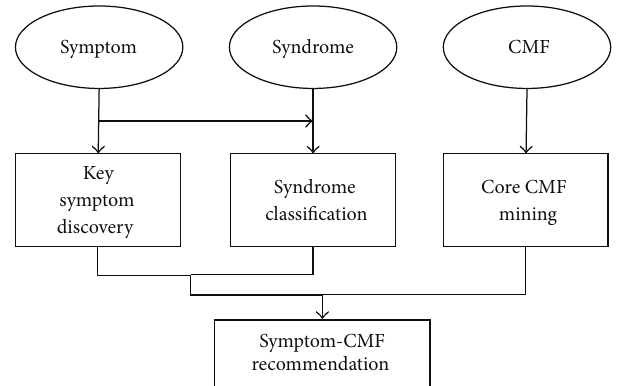
Figure 6: Framework of TCM clinical data analysis.